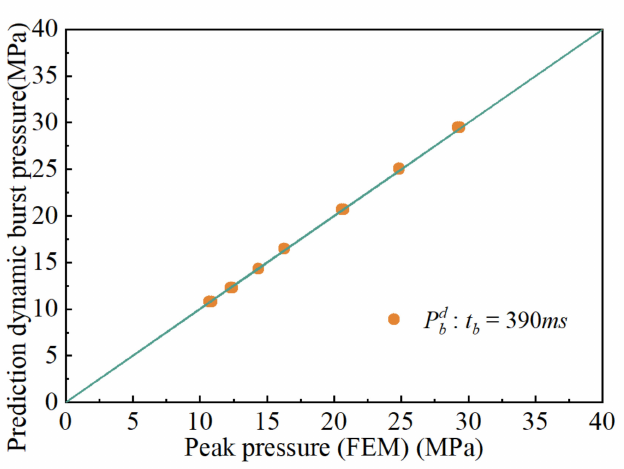
Figure 9. Comparison results obtained when t d =